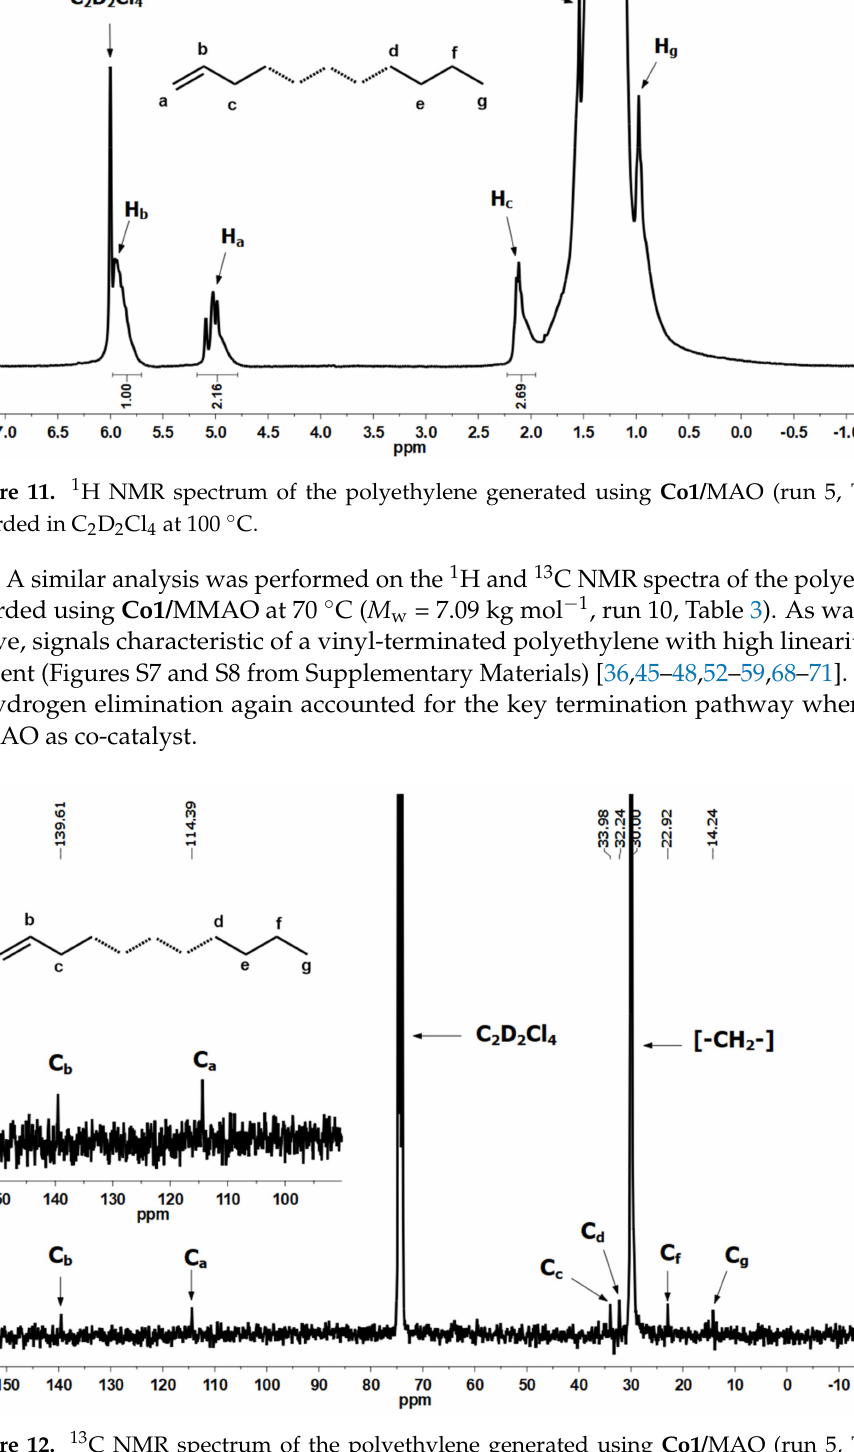
Figure 12. 13 C NMR spectrum of the polyethylene generated using Co1/ MAO (run 5, Table 2); recorded in C 2 D 2 Cl 4 at 100 ◦